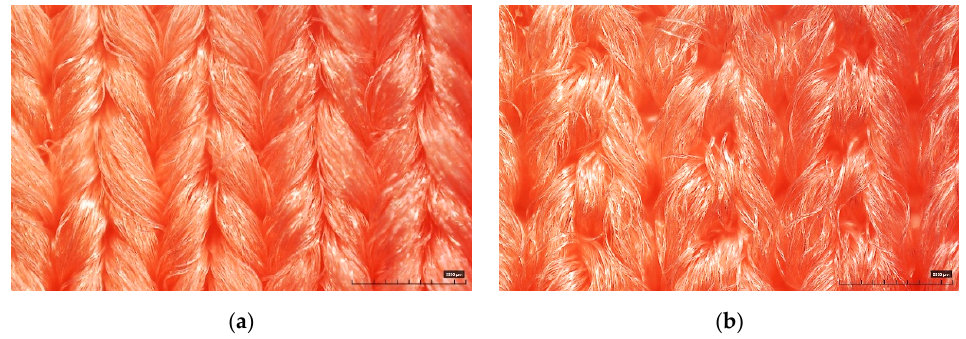
Figure 1. The morphology of substrate fabric used in this study: ( a ) Face side; ( b ) back